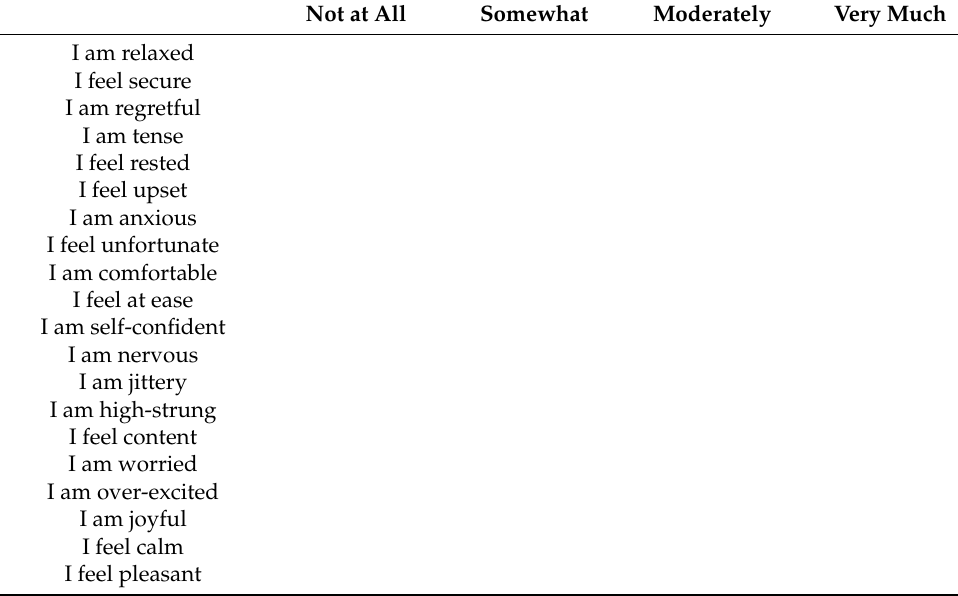
Table A2. State-Trait Anxiety Inventory (STAI)